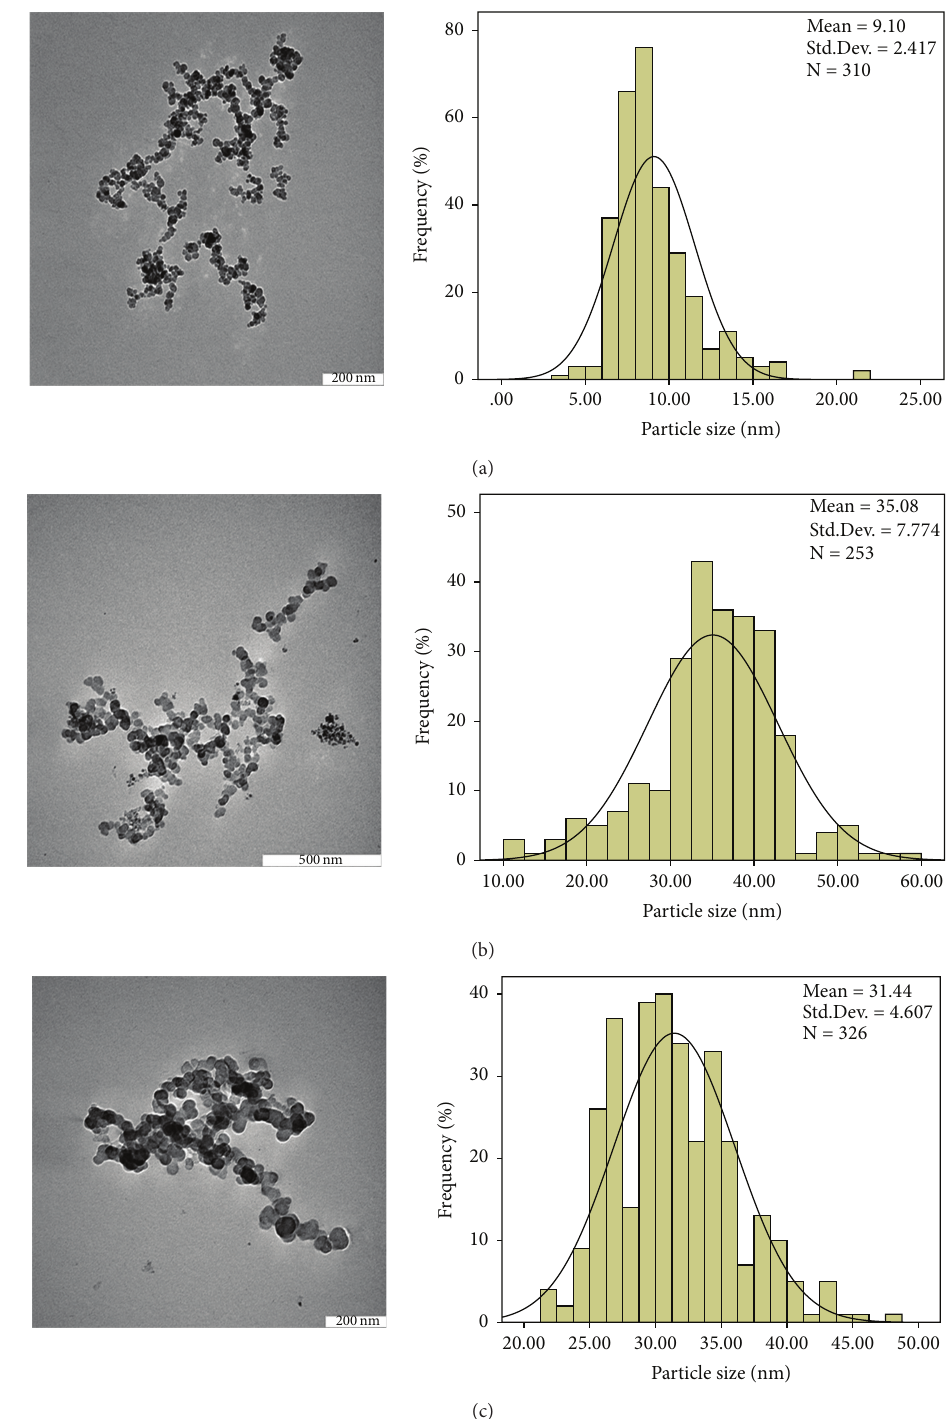
Figure 5: TEM micrographs of (a) FNP with 200 nm microbar and the particle size distribution, (b) FPVAG with 500 nm microbar and its particle size distribution, and (c) FPEGG nanocomposite with 200 nm microbar and the particle size distribution.